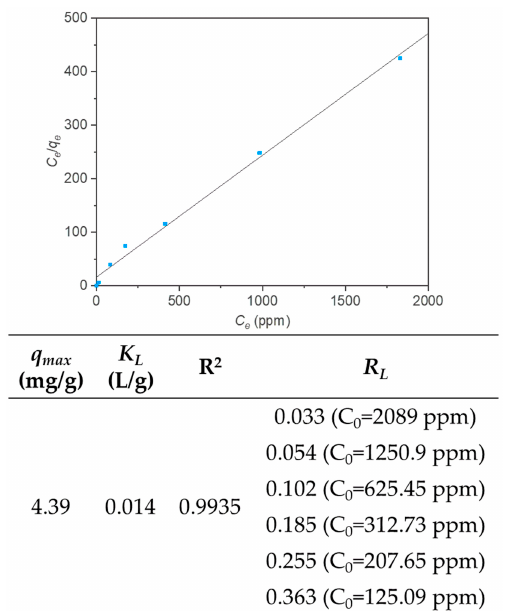
Figure 5. Fitting of experimental data with the linearized Langmuir isotherm model for phenols in OMW. The table reports calculated values from Equations (6) and (7).